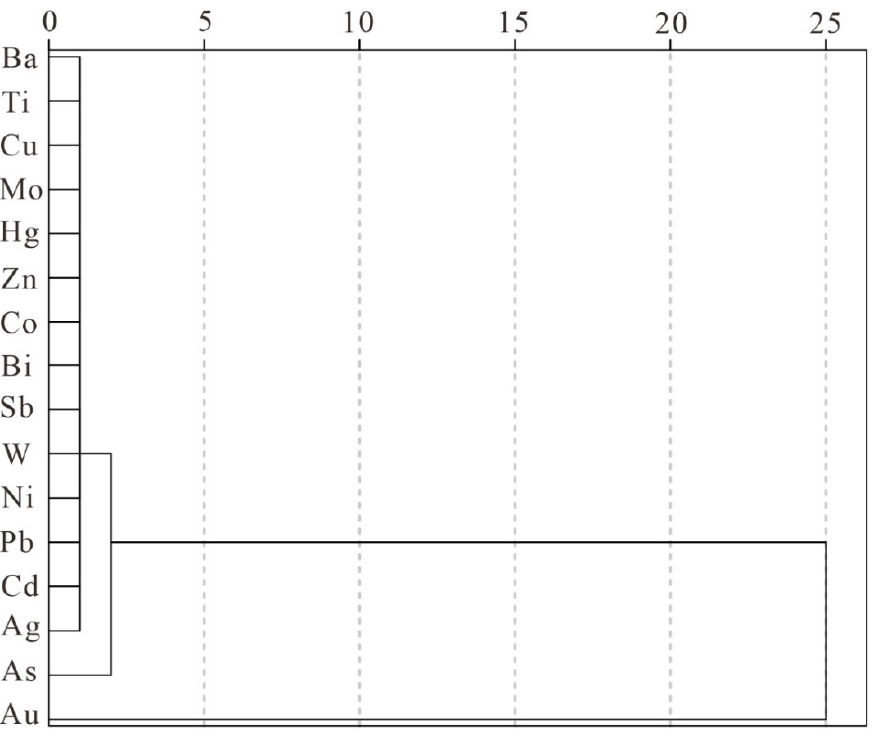
Figure 8. Cluster analysis diagram of element abnormality in the Yanjingou Au deposit.